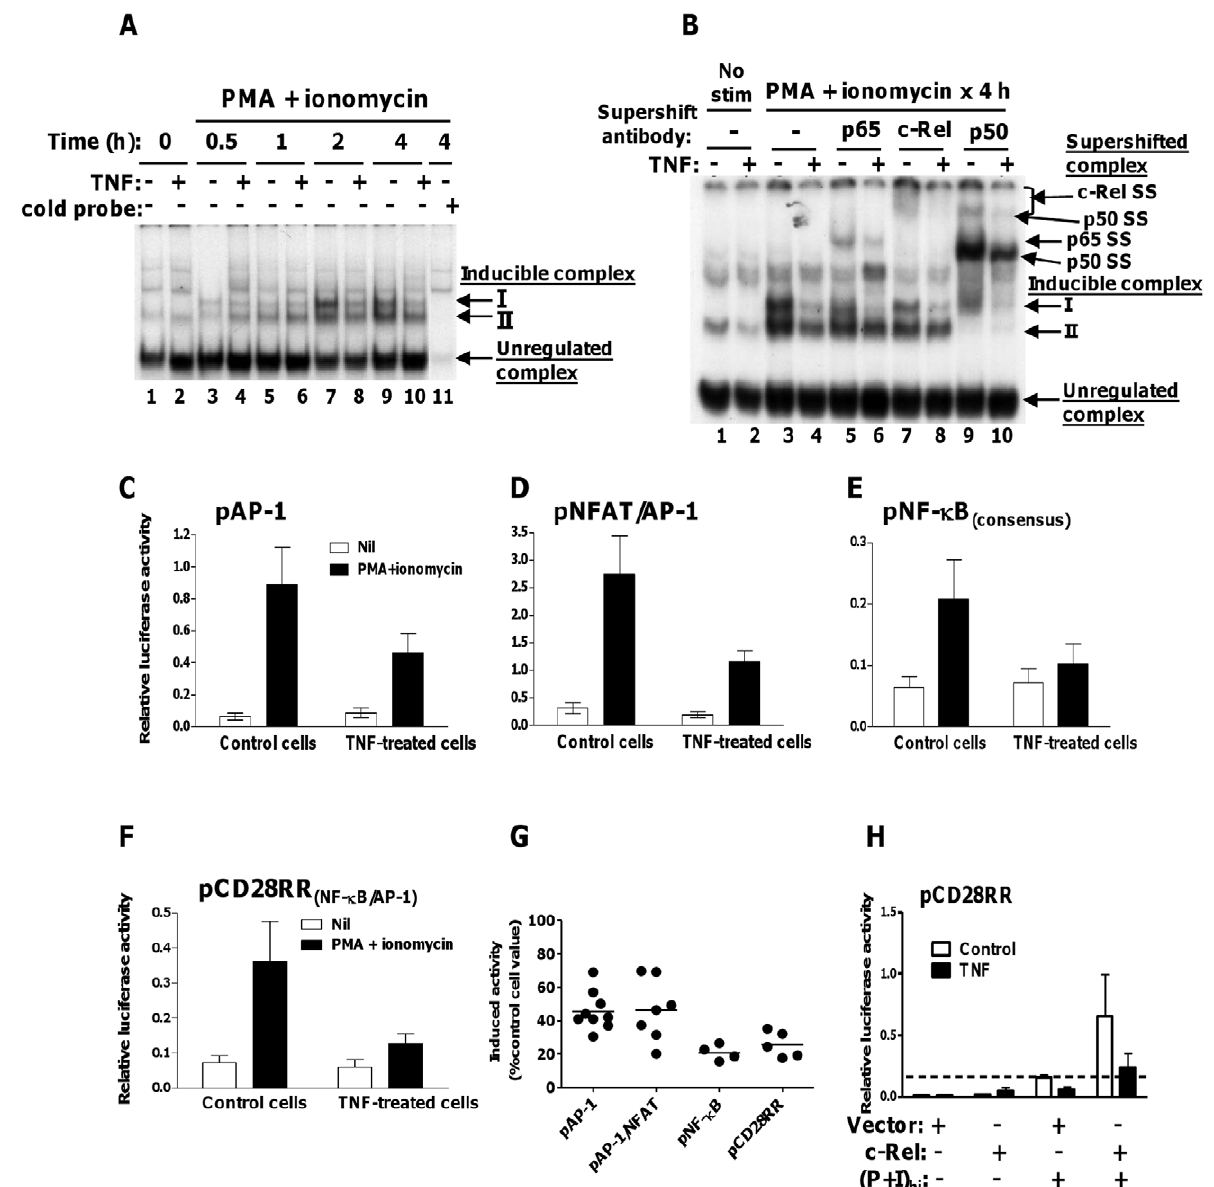
Figure 3. Transcription factor DNA binding and activity are suppressed by TNF. Activation of pCD28RR partially restored by exogenous c- Rel. Control and TNF-treated 11A2 T cells were activated with (P + I) high . Nuclear extracts were incubated with (A) 32 P-labelled NF- k B consensus oligonucleotide or cold competitor probe or (B) 32 P-labelled NF- k B oligonucleotide with or without NF- k B supershifting antibodies, before non- denaturing gel electrophoresis. Protein-bound oligonucleotide was visualised by both phosphorimaging and exposure of the dried gel to photographic film. Images are representative of three experiments. Control and TNF-treated cells were transfected with reporter plasmids (10 m g) expressing firefly luciferase under control of (C) pAP-1, (D) pNFAT/AP-1, (E) pNF- k B consensus , (F) pCD28RR (NF- k B/AP-1) promoters, and stimulated as above for 6 hours. Firefly luciferase expression relative to pSV40-driven renilla luciferase from a co-transfected plasmid (0.2 m g) is shown (mean + / 2 SEM for 9, 7, 4 and 5 experiments, respectively). (G) Summary of inducible promoter activities in TNF-treated cells as a percentage of induction in control cells, for all experiments. (H) Control and TNF-treated 11A2 cells were cotransfected with 2 m g of empty vector or c-Rel expression plasmid and pCD28RR reporter plus renilla luciferase plasmids prior to stimulation as for F. The dotted line represents stimulated expression in cells transfected with empty vector (mean + / 2 SEM, n=4 experiments).